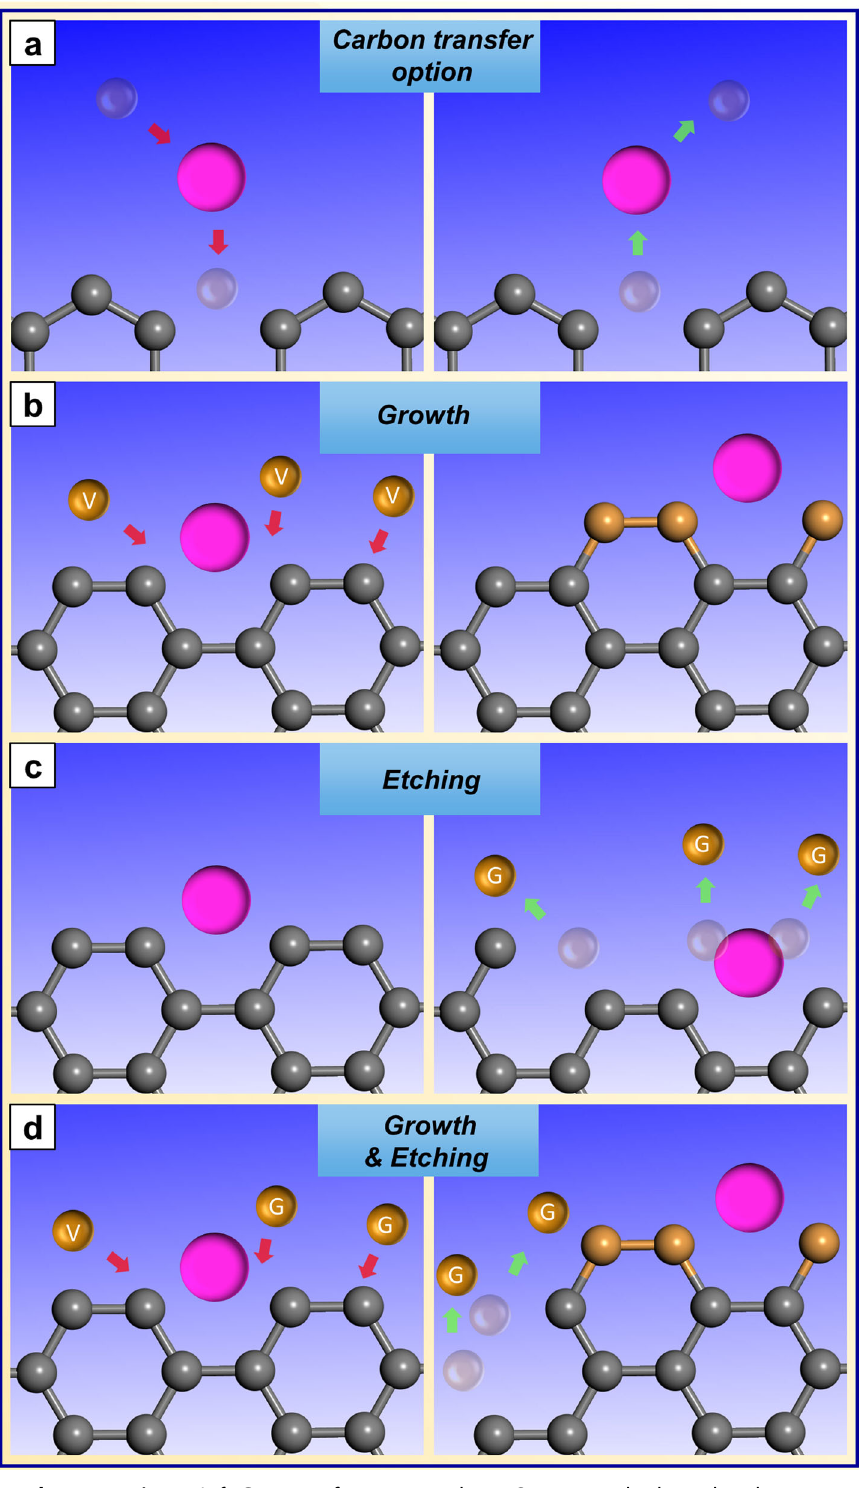
Fig. 13 Schematic fi gures demonstrating. a Left : C capture from vacuum by an Sn atom and subsquebt release to a graphene edge (growth). Right : C capture from a graphene edge and release to the vacuum (etch). b Schematic showing the catalytic growth of graphene from a single Sn atom with a plentiful C supply in vacuum. c Schematic showing the catalytic etching of graphene from a Sn atom due to a lack of C atoms in vacuum. d Schematic showing catalytic growth and etching of graphene at the same time with a limited C supply in vacuum. The rose-red balls indicate a Sn atom. The orange balls with red arrows indicate newly inserted C atoms. The orange balls with green arrows indicate captured/removed C atoms. The translucent orange balls represent the previous positions of the C atoms. The V symbol and G symbol marked on the C atom represent if the carbon atoms were captured from vacuum or graphene, respectively. Reproduced with permission from Wiley- VCH GmbH 48 .